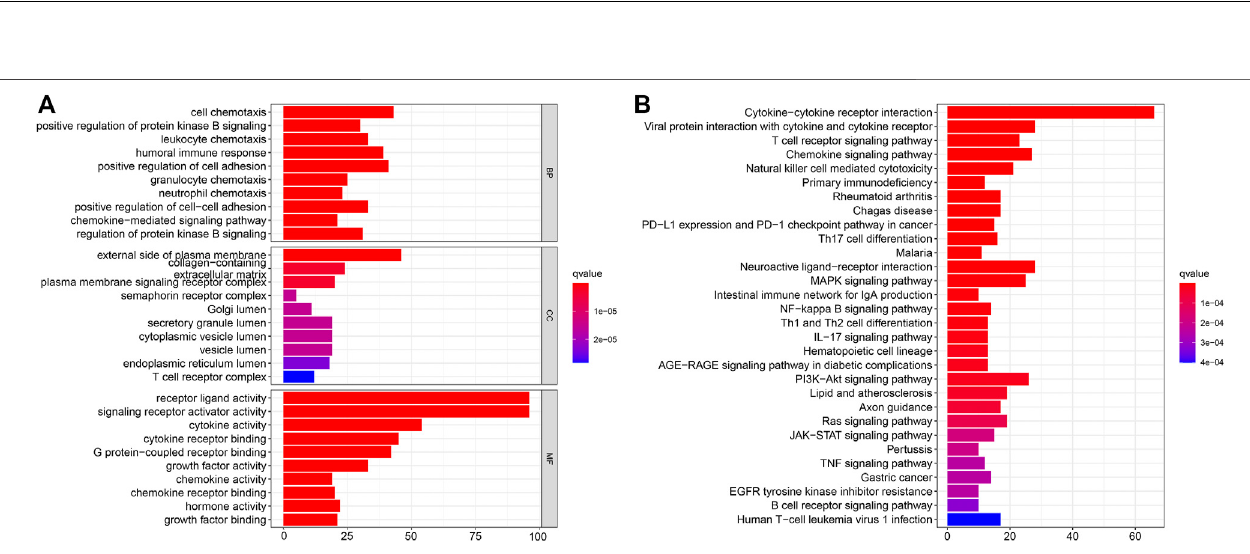
FIGURE3| EnrichmentanalysisofIRDEGs. (A) GOenrichmentanalysis. (B) KEGGpathwayenrichmentanalysis.IRDEGs,immune-relateddifferentiallyexpressed gene; GO, gene ontology; KEGG, Kyoto Encyclopedia of Genes and Genomes; BP, biological process; CC, cellular component; MF, molecular function.